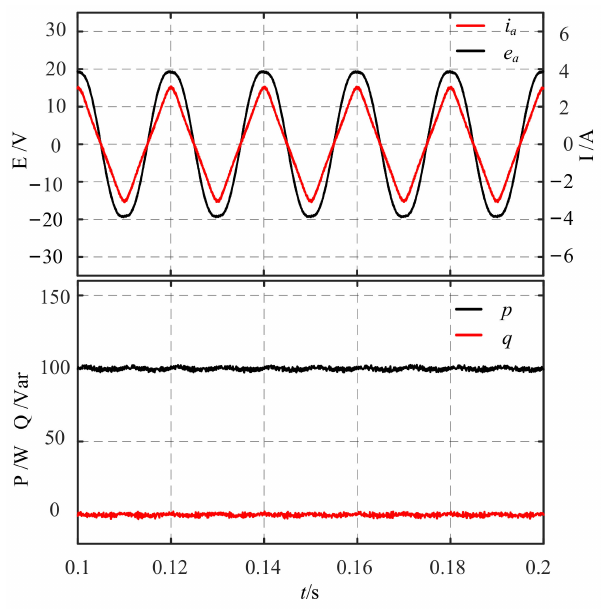
Figure 5. Instantaneous power waveform of conventional